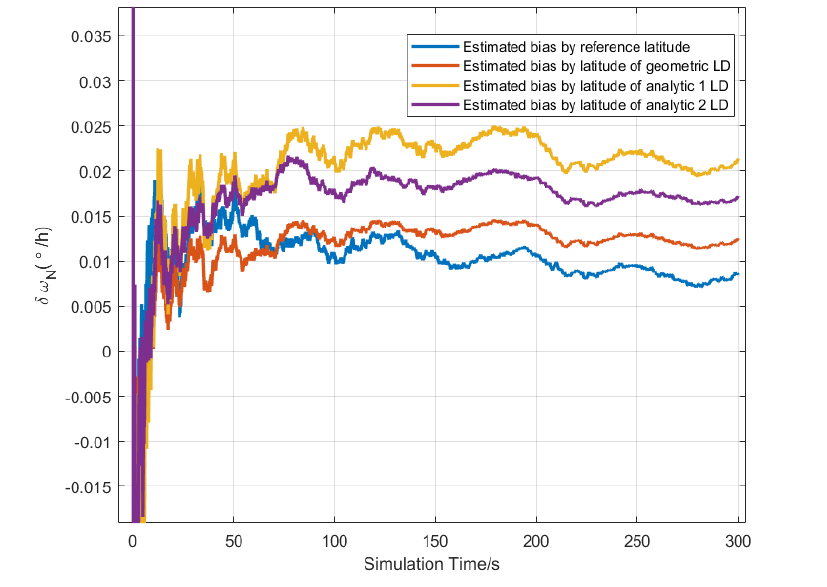
Figure 4. The bias estimation curve of the northward gyro by latitude of different LD